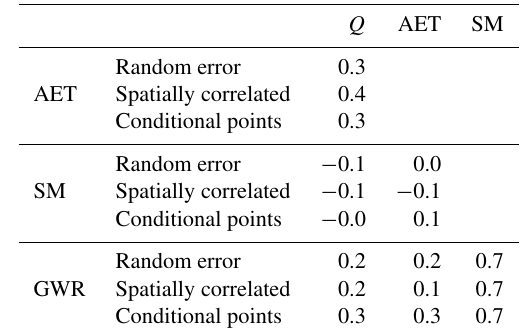
Table 3. Correlation matrix of the uncertainty (CV) of the model outputs ( Q is generated runoff; AET is actual evapotranspiration; SM is soil moisture; GWR is groundwater recharge) obtained with the three perturbation methods (random error, spatially correlated and conditional